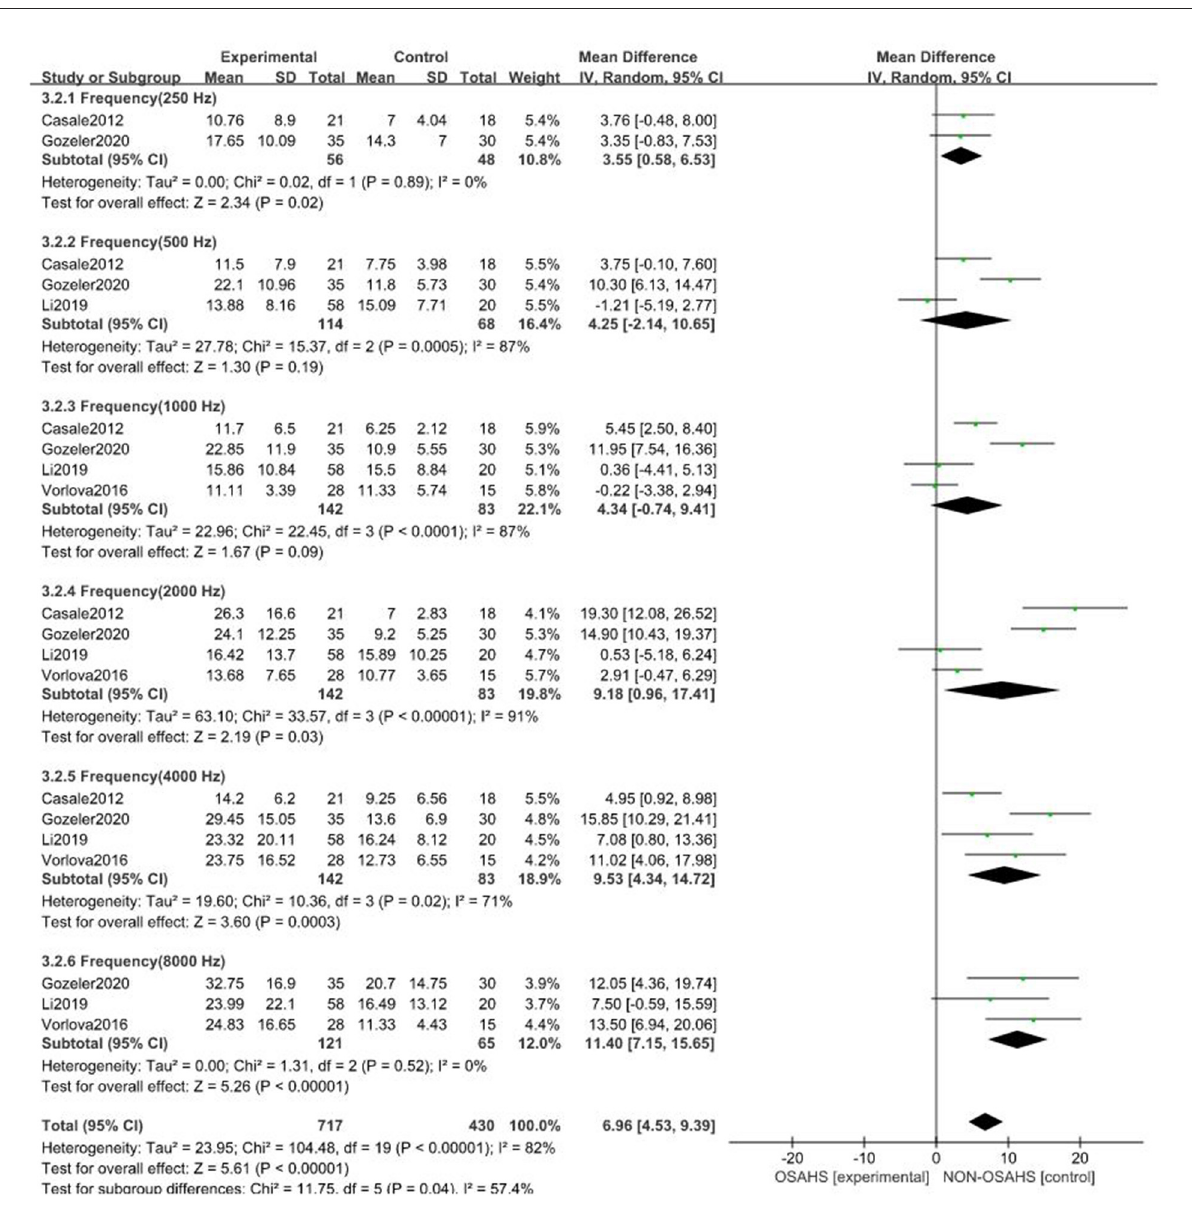
FIGURE4 Forest plot of pure-tone hearing threshold correlation between OSAHS group and control group with different audiometric test